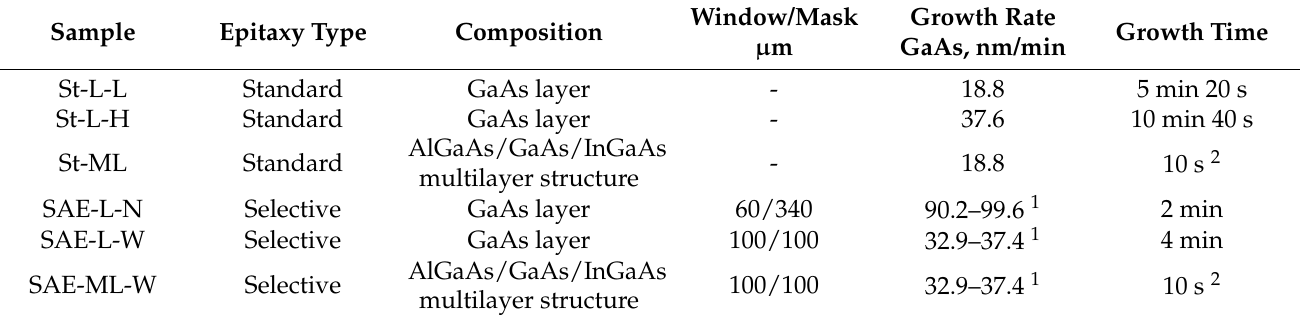
Figure 1. Schematic views of samples grown using ( a ) standard MOCVD of GaAs layers (St-L-L and St-L-H) and ( b ) Selective area epitaxy (SAE) of GaAs layer on the patterned substrate with window/mask widths of 100/100 µ m (SAE-L-W) (atomic force microscope (AFM) scan points: A—12–17 µ m, B—48–53 µ m, C—85–90 µ m), as well as samples of heterostructures with InGaAs quantum wells (QWs) grown using ( c ) standard MOCVD (St-ML) and ( d ) SAE on the patterned substrate (SAE-ML-W) (I—standard epitaxy, II—SAE). See description of samples in Table 1. Table 1. Description of experimental samples.